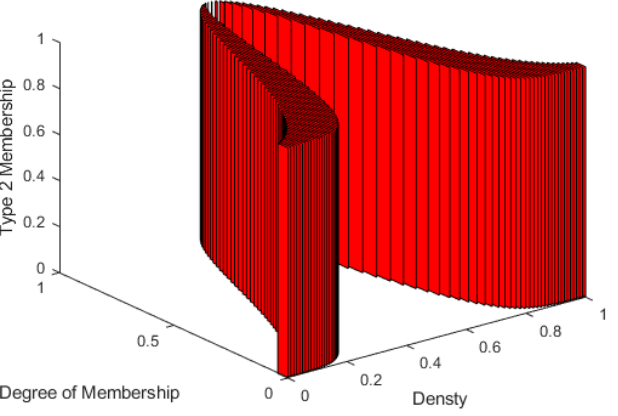
Figure 10. 3D representation of medium Type-2 membership function used for the density input feature.